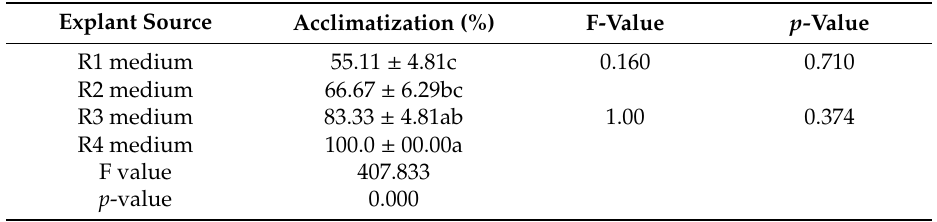
Table 7. Comparison of the average acclimatization (% ± SD) of germinated SEs after 6 weeks of growth in peat moss soil.